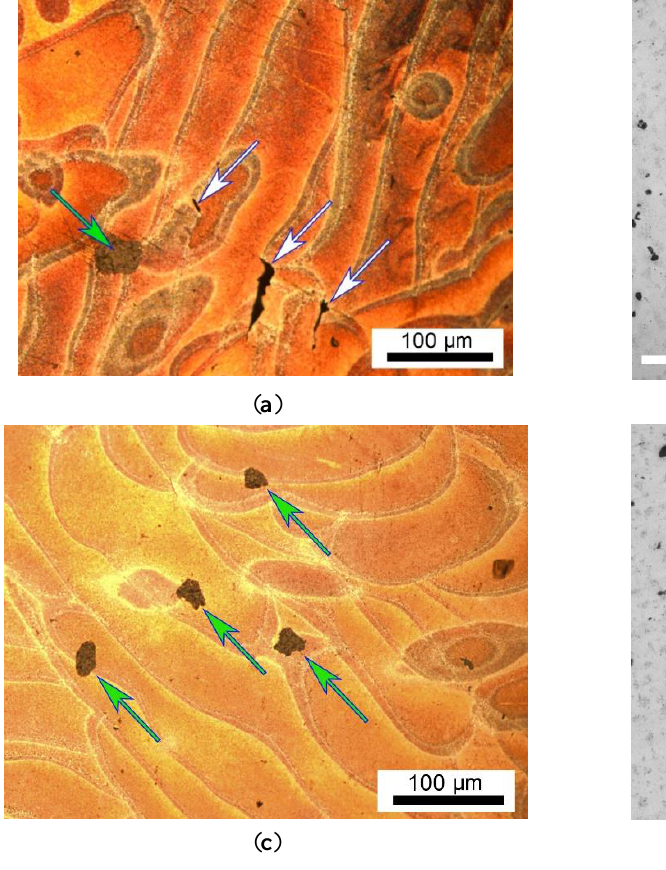
Figure 5. Optical microscopy images of etched and polished surfaces of AlSi10Mg/AlN composite printed with P = 200 W and V = 600 mm/s ( a ) and ( b ) and with P = 350 W and V = 1200 mm/s ( c ) and ( d ). Pores are shown by white arrows, whereas AlN particles are shown by green arrows.